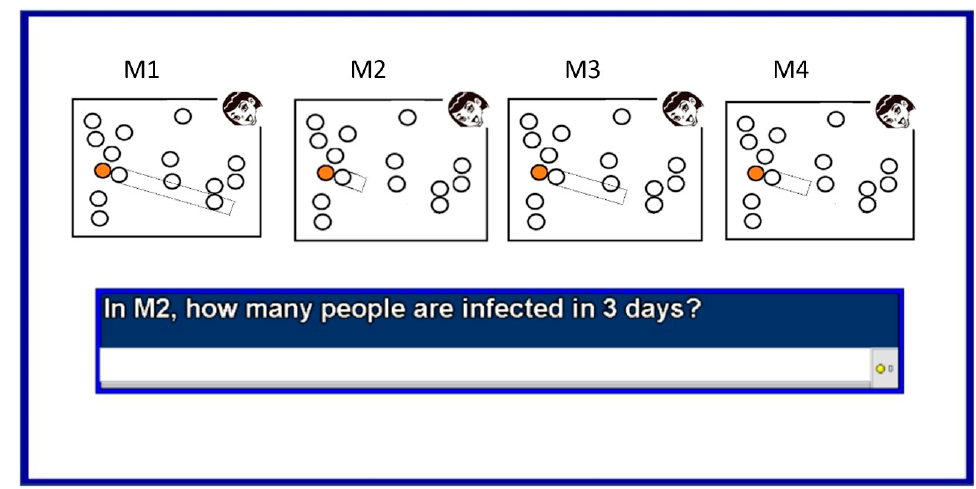
Figure 18. Example of a question that tested whether students understand an extension of the pool table model that includes population mobility.